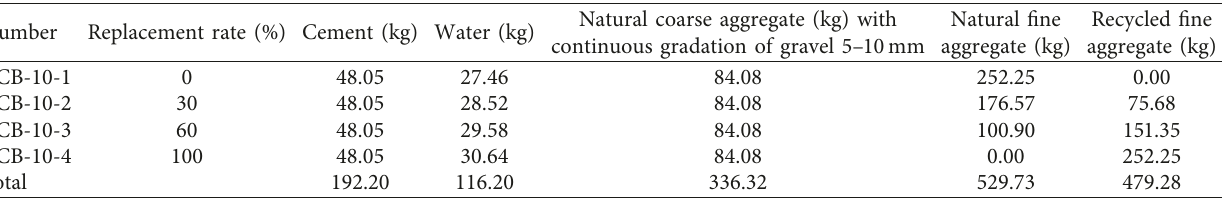
Table 1: Quantity of materials required for the MU10 block experiment.